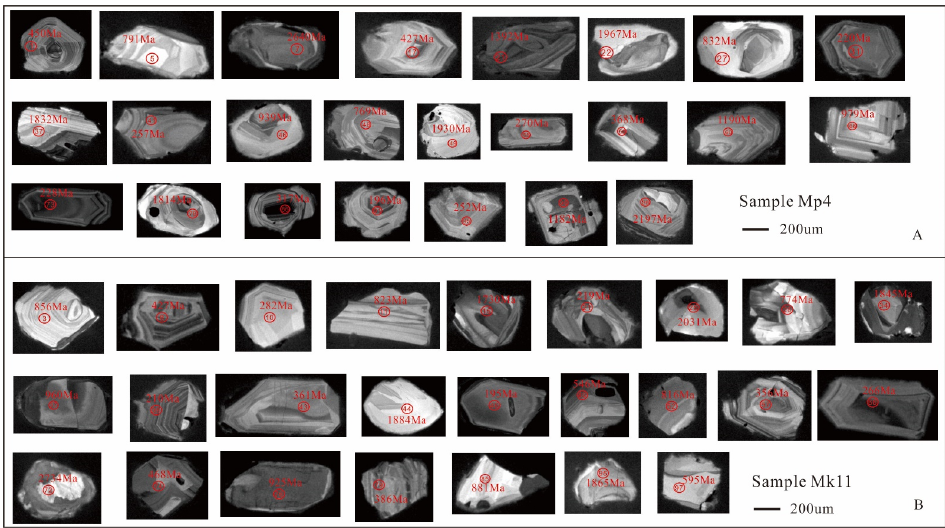
Figure 6. Representative cathodoluminescence images for detrital zircon grains of sandstone samples from Qamdo. The laser spots and corresponding ages are marked. ( A ) Sample MP4 of Mangda section. ( B ) Sample MK11 of Mangkang section.